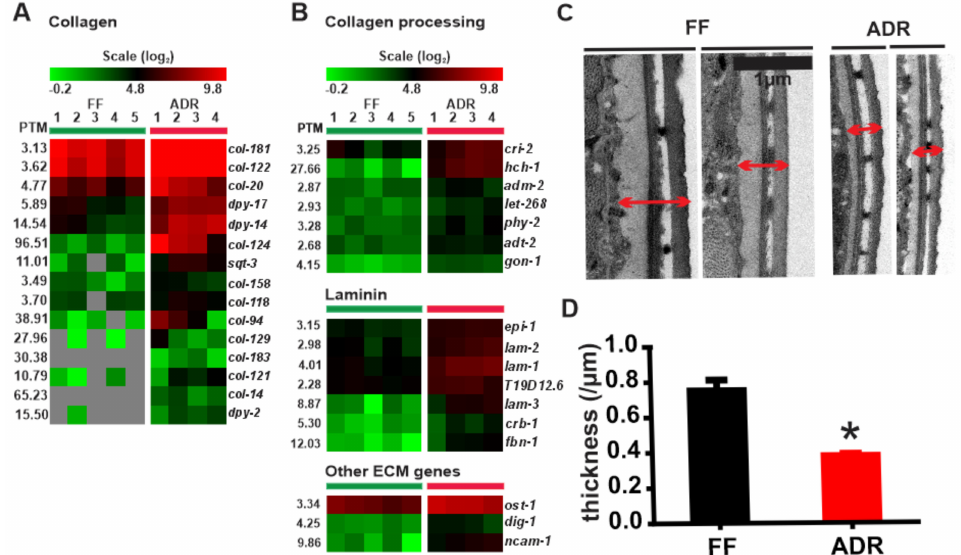
Figure 7. Expression levels of collagens ( A ) and genes involved in collagen processing, laminin, and other extracellular matrix genes ( B ) in fully fed (FF) and axenic dietary restricted (ADR) worms. ( C ) TEM images of cuticles of worms grown in FF (fully fed) and ADR (axenic dietary restriction) conditions. Red arrows = cuticle thickness. ( D ) Cuticle thickness in FF (fully fed) and ADR (axenic dietary restriction) worms, *: p <